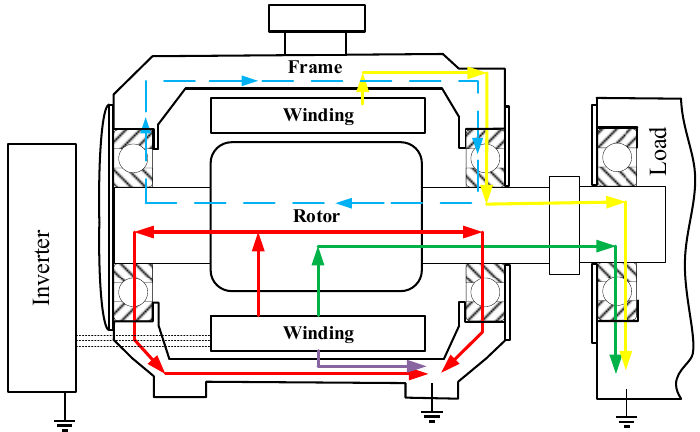
Figure 9. Bearing current paths in an inverter-driven induction motor system.